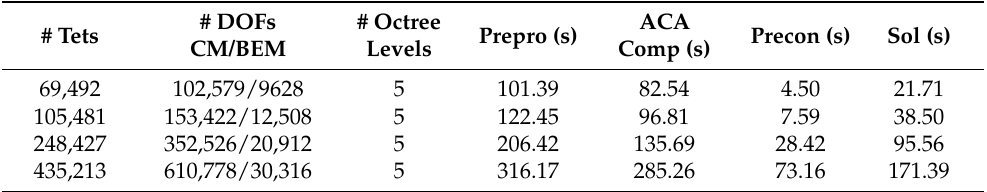
Table 7. Computation times for the CM-BEM software with ACA compression (prepro: preprocessing,